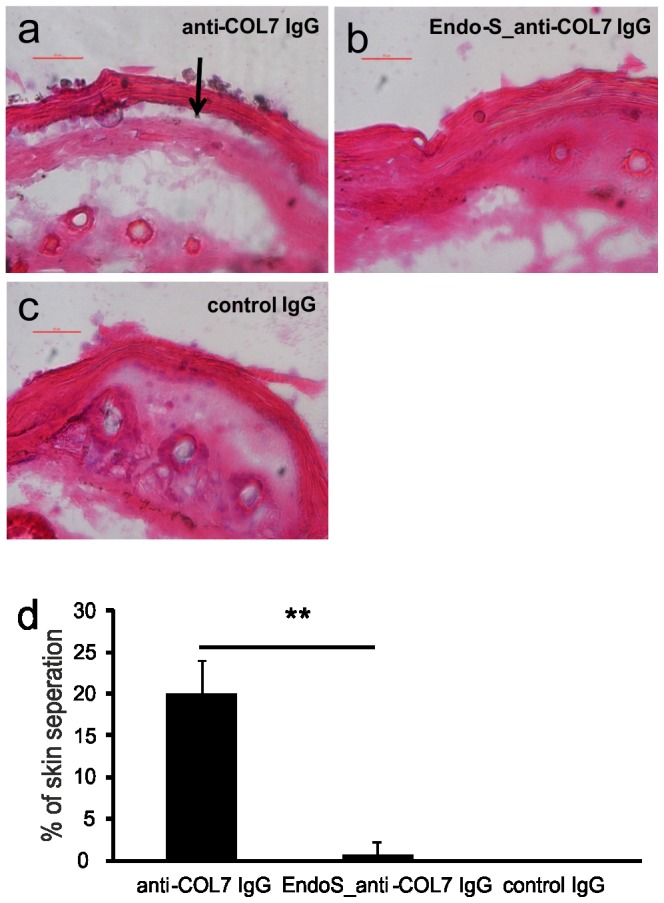
Effect of EndoS treatment of anti-mCOL7 IgG on tissue damage in an ex vivo model of EBA.Mouse skin cryosections were incubated with 0.2/ml rabbit-anti-mCOL7 IgG (a), or EndoS-treated 0.2 mg/ml rabbit-anti-mCOL7 IgG (b) or rabbit control IgG (c) for 1 hour at 37°C. Subsequently, specimen were exposed to freshly isolated human neutrophils. Sections of a representative experiment are shown. Arrows indicate the dermal-epidermal separation. Bar = 50 µm. Furthermore, skin separation was quantified as percentage of the length of epidermis detachment in relation to the length of the total dermal-epidermal zone (d). Data are presented as mean ± s.d. of 4 independent experiments. **indicates statistically significant differences (p<0.01) between EndoS-treated and untreated IgG.